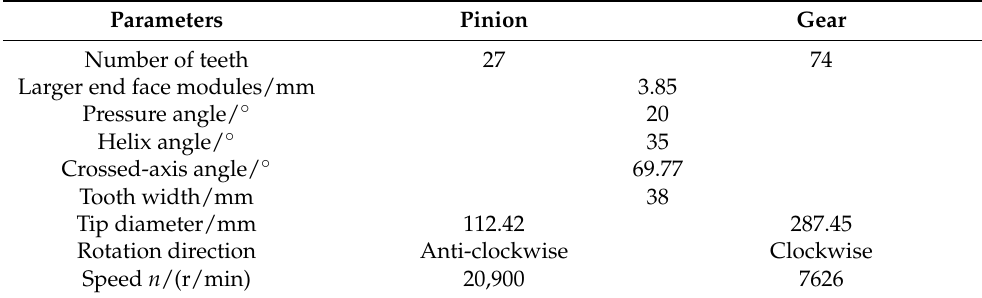
Table 1. Basic parameters of spiral bevel gear.